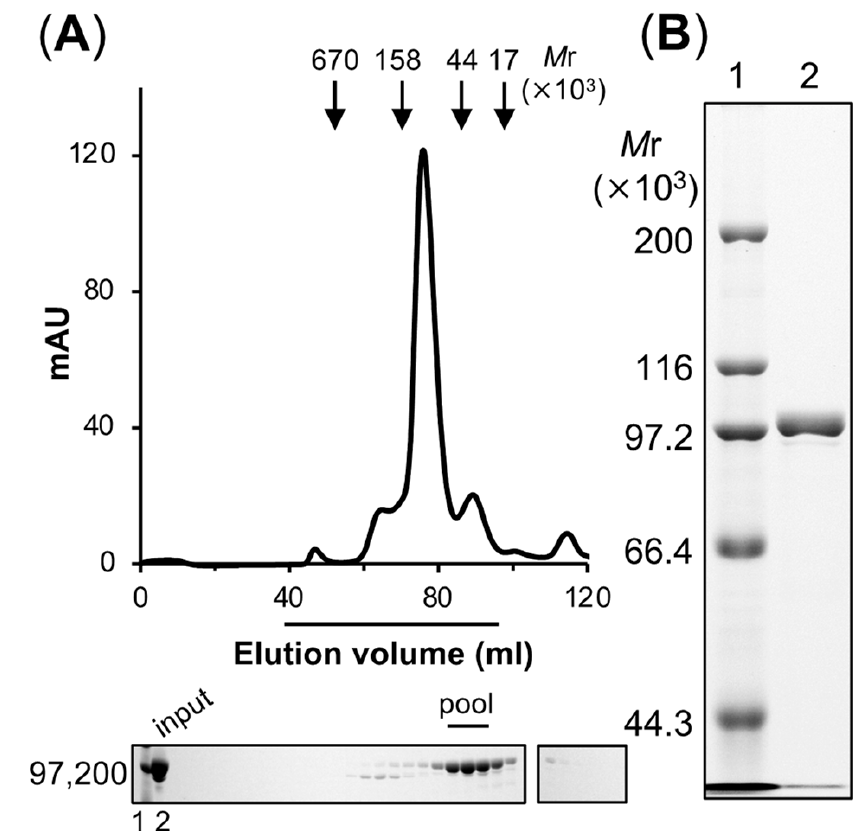
Figure 1. Preparation of recombinant Sac aLhr1 protein. ( A ) Gel filtration chromatography of Sac aLhr1 following His-tag purification. Arrowheads indicate the elution profile of standard marker proteins, and the numbers indicate relative molecular masses. Fractions indicated by underbar were subjected to SDS-7.5% PAGE followed by staining with Coomassie Brilliant Blue (CBB) and are shown under the chromatogram. Lanes 1 and 2 are the protein marker ( M r, 97,200) and input, respectively. Three fractions were pooled and used for subsequent experiments. ( B ) Protein markers (lane 1) and the purified Sac aLhr1 (1 µ g) (lane 2) were separated using SDS-7.5% PAGE and stained with CBB. Sizes of the markers are shown to the left of the panel.